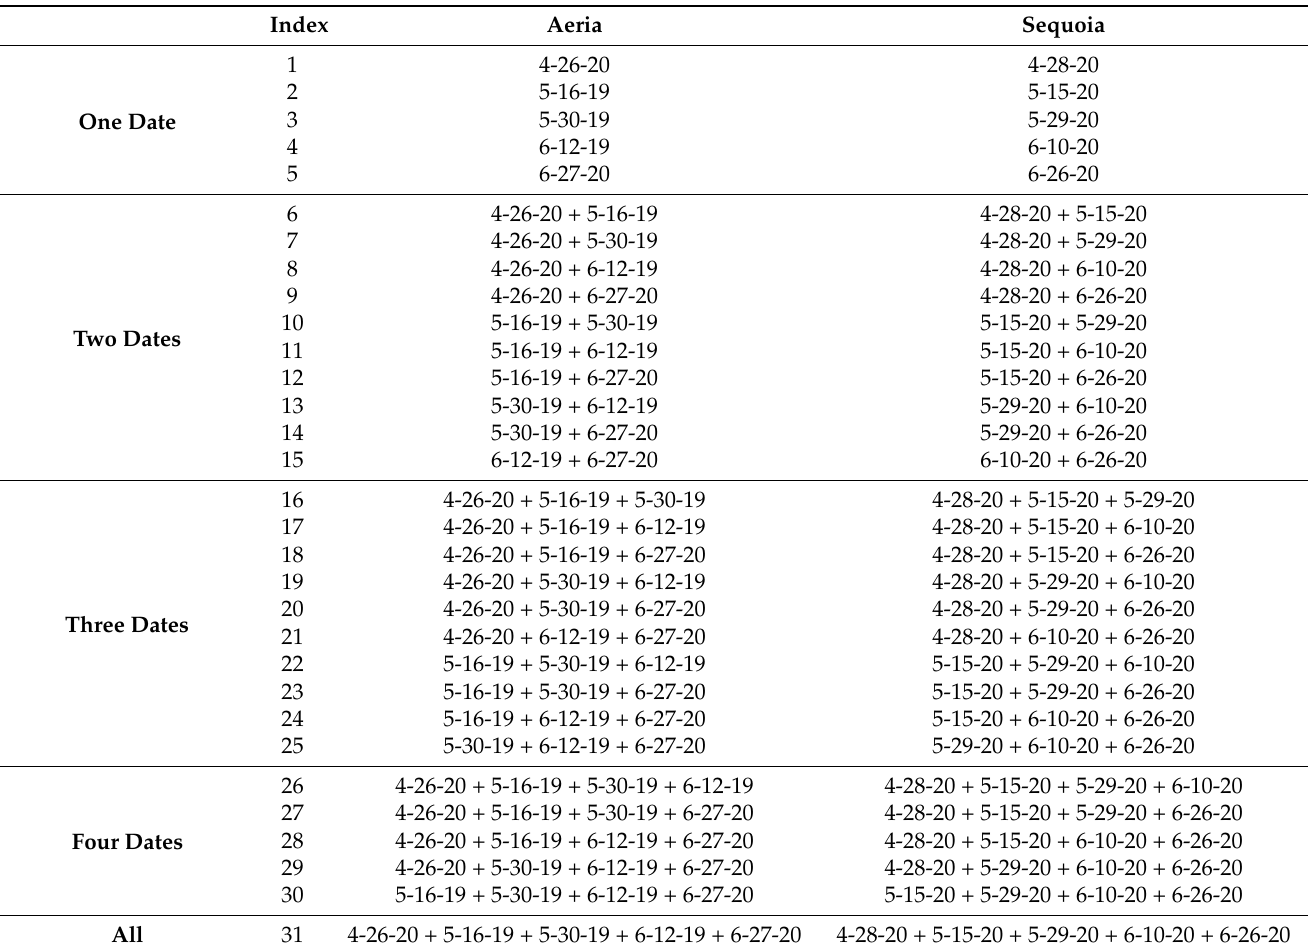
Table 4. All single- and multi-date image stacks for classification grouped by the number of dates included and indicated on the far-left. The index column is a unique identifier assigned to each combination within a